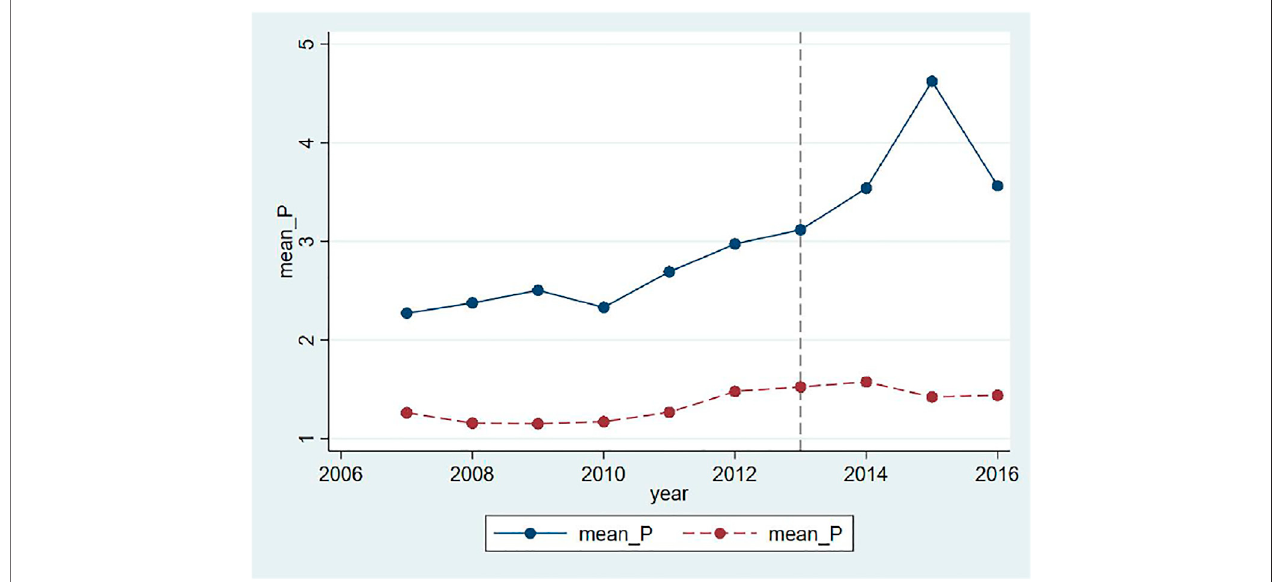
FIGURE 1 | Time trend chart of the mean value of